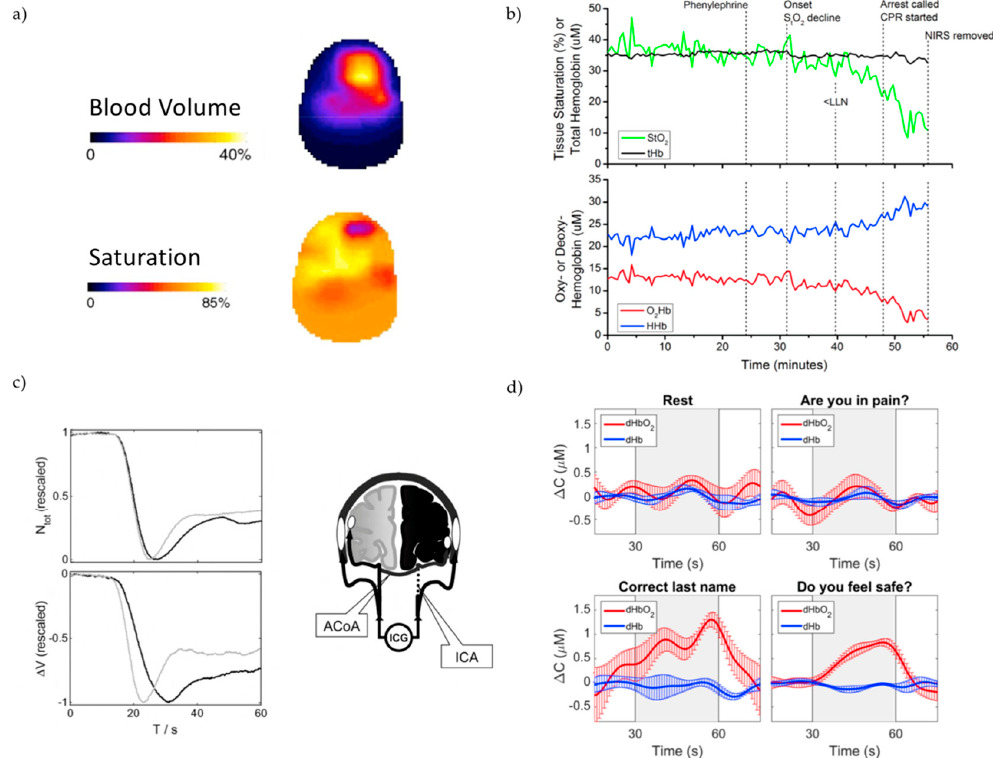
Figure 5. Example of the data produced by TD-NIRS systems. ( a ) Coronal slices of tomographic images of the blood volume and the StO 2 of a baby who had a left ventricular haemorrhage. The haemorrhage can be seen as an increase in blood volume and a decrease in oxygen saturation. Extracted from [69]. ( b ) StO 2 and haemoglobin concentration ([tHb]) in a patient with septic shock during the hour prior to a pulseless electrical activity arrest and cardiopulmonary resuscitation (CPR). The decrease in StO 2 can be seen 15 min prior to the arrest. Extracted from [95]. ( c ) Illustration of a measurement from [86], on a patient with an internal carotid artery (ICA) occlusion on the a ff ected side and a crossflow over the anterior communicating artery (ACoA). The anatomical situation and the influence on the bolus passage are shown schematically on the right diagram, with the a ff ected hemisphere shown in black colour and the una ff ected one shown in light grey. The left side of the figure compares the conventional CW-NIRS based approach, which is represented by the time-integrated signal N tot to the moment TD-NIRS approach based on the analysis of variance. The colours of the bolus curves correspond the diagram (black: a ff ected hemisphere, light grey: una ff ected hemisphere). In the CW-NIRS approach, the bolus curves di ff ered only slightly. In contrast, in the TD-NIRS approach, the variance signals showed a significant di ff erence between the hemispheres. ( d ) Example of brain activity of a patient with locked-in syndrome during mental imagery (MI), from [107]. The “rest” period corresponds to data acquired without MI activation and is presented as a reference for the contrast observed during the question periods. If the answer was “Yes” the patient was asked to perform a MI task (i.e., play tennis). If the answer was “No”, the patient was asked to rest. The grey boxes indicate the response period. One can see that the patient responded “yes” to two questions. At the time of this study, the patient had regained limited eye movement, so those responses could be